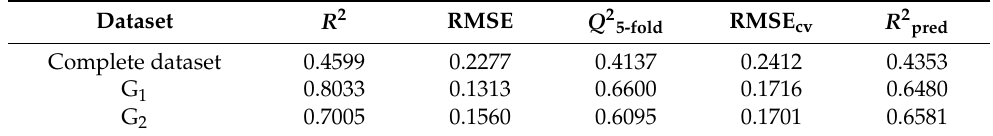
Table 5. Statistically significant 4D-QSAR